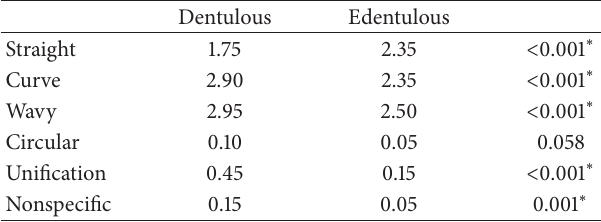
Table 3: Table showing the mean value and statistically significant P value in different rugae patterns of dentulous and edentulous